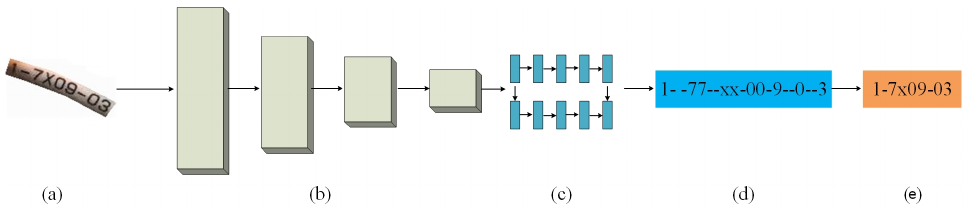
Figure 4. The overall pipeline of recognition. ( a ) is the input image. ( b ) is the convolutional layers. ( c ) is the recurrent layers. ( d ) is the lexicon-free transcription layer. ( e ) is the final recognition